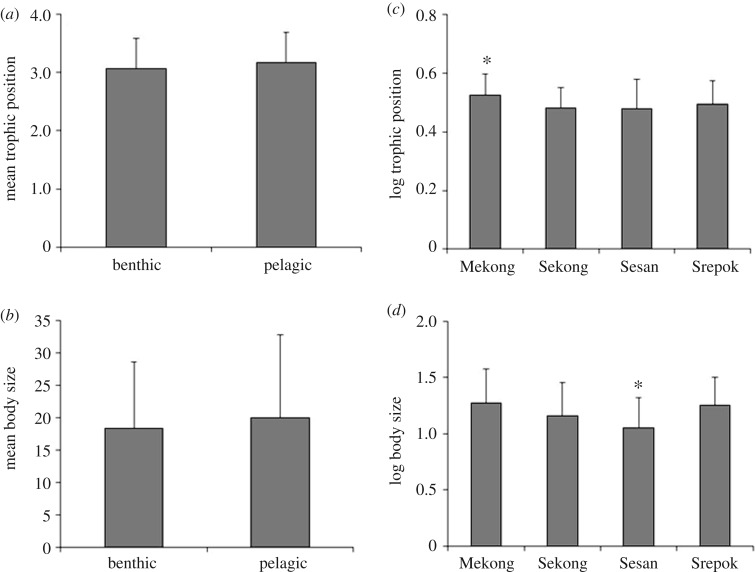
Mean (±s.d.) of trophic position (a) and body size (b) of fish assemblages in benthic versus pelagic habitats, and of trophic position (c) and body size (d) across four rivers. Asterisk above bar denotes significant difference (p < 0.05) from other groups.